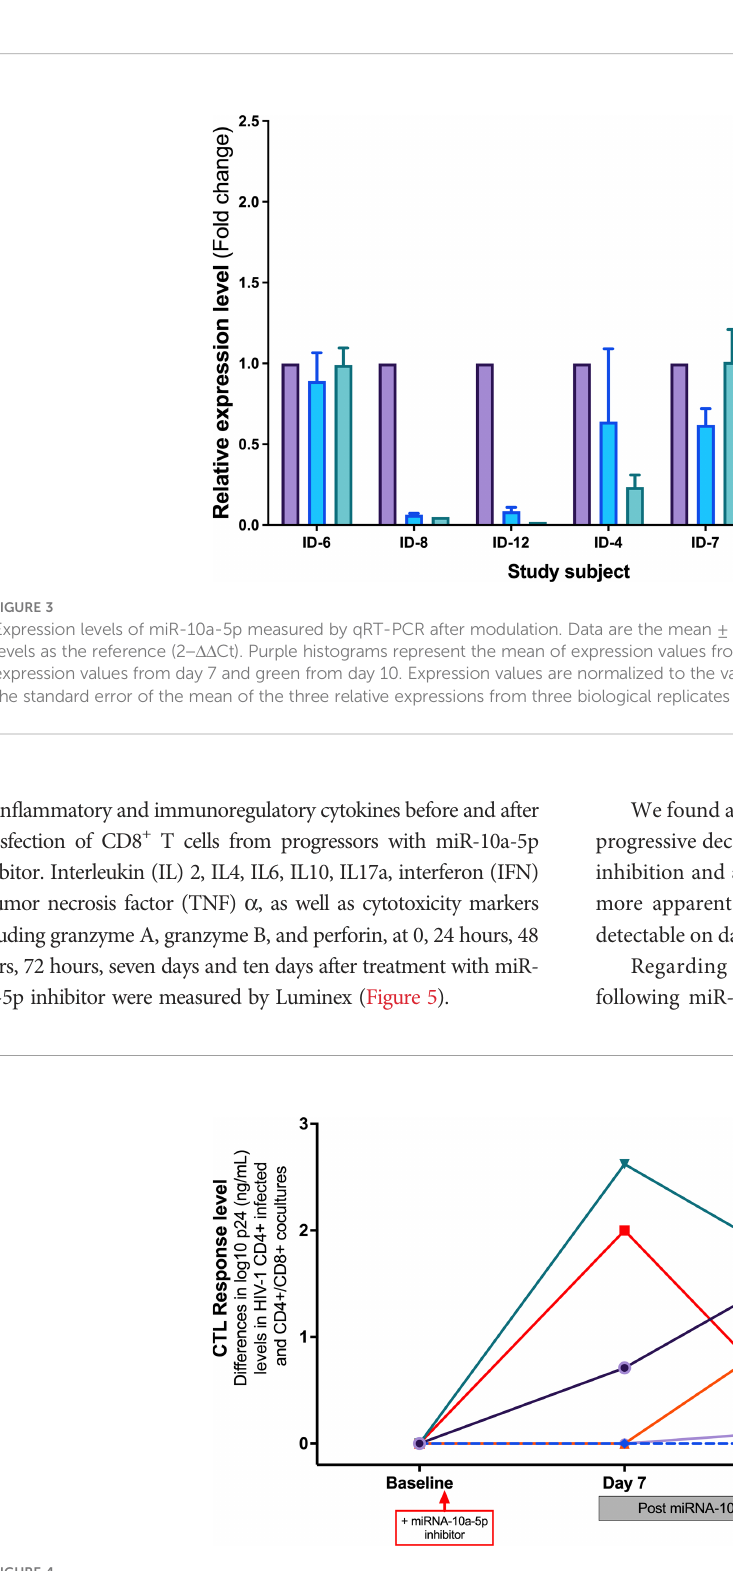
FIGURE 4 Impact of transfected miR-10a-5p inhibitor in CD8 + T cells from progressors at day 7 and at day 10 post-treatment on CTL response level, measured as the reduction in log10 p24 levels at baseline and at days 7 and 10 after miRNA-10a-5p inhibition. A reduction of p24 antigen ≥ 1 log 10 was considered a relevant increase of CD8 + CTL response. For each experiment, we used three biological replicates and two technical duplicates.